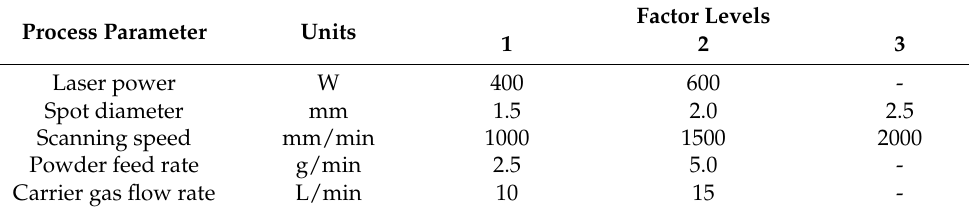
Table 2. Taguchi orthogonal L36 preliminary single-track experimental plan. Process Parameter